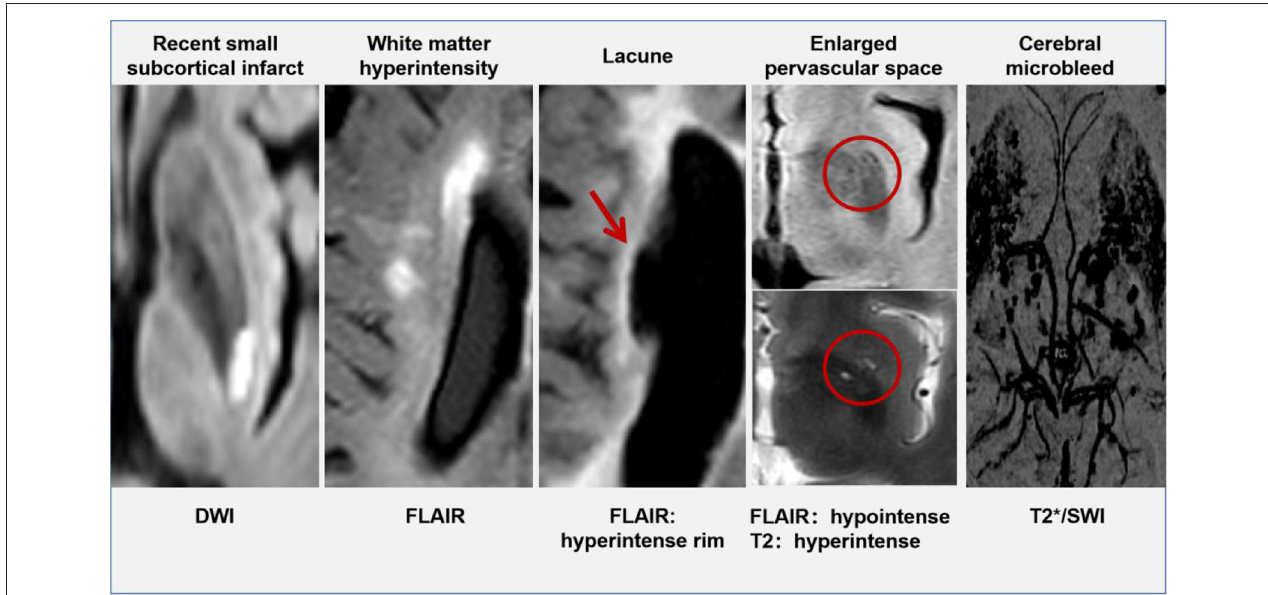
FIGURE 1 | The typical manifestation of cerebral small vessel disease (CSVD) on